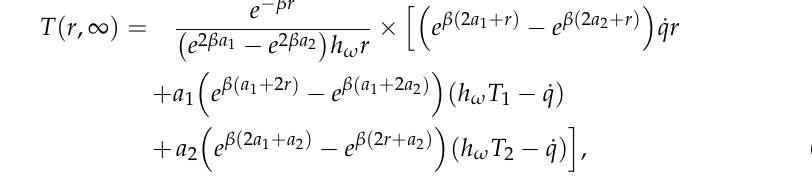
= 0. ( b ) Steady r = a 2